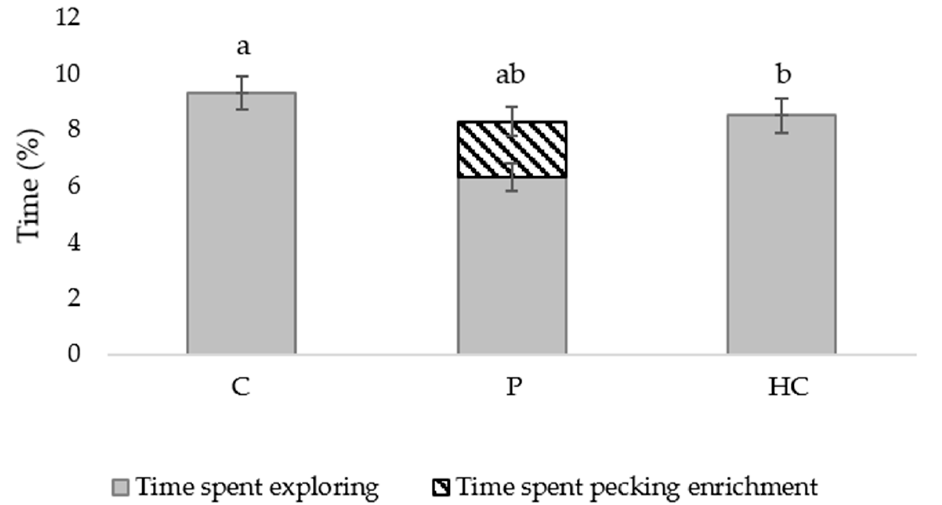
Figure 2. Mean proportion of time ( ± SEM) spent exploring (foraging and ground pecking; solid grey bars) and pecking at environmental enrichment items (striped bar; only applicable to P birds) between birds that were raised under standard conditions (C), with additional physical items (P) or with additional human contact (HC). Subscript (a, b, ab) refers to treatment differences when pecking enrichment was included to exploring; differing subscript denotes a treatment effect at p < 0.05. When pecking enrichment items was not included in the analysis (i.e., solid grey bars only) P birds spent less time exploring than C and HC birds ( p < 0.001; subscript/significance not